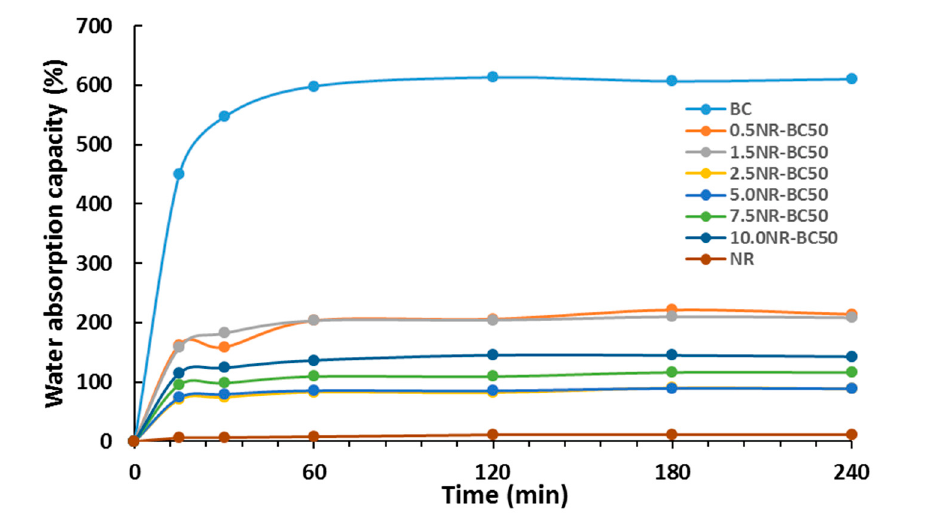
Figure 10. Water absorption capacity (WAC %) with time of NR–BC50 films.